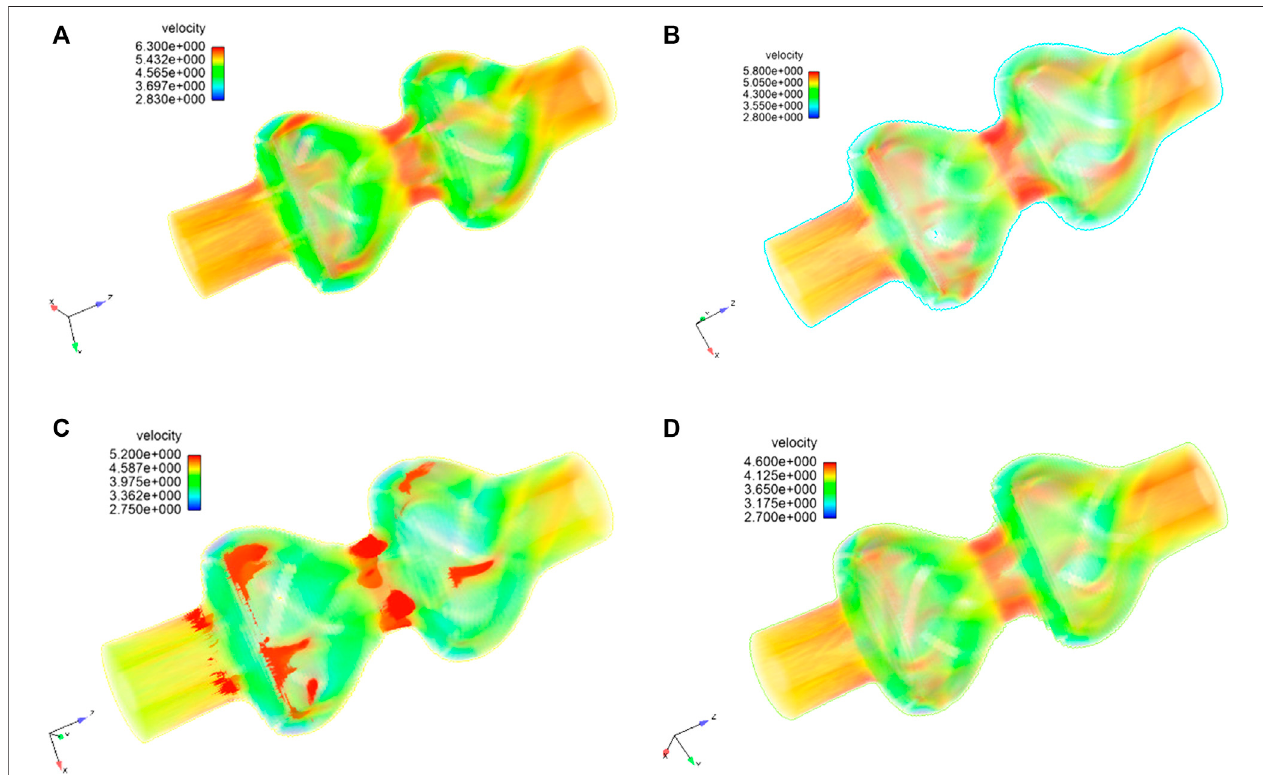
FIGURE3| Axialvelocityclouddiagramsofthe fl ow fi eldofthetwo-stagedeep-sealiftingpump: (A) 1,100 rpm, (B) 1,200 rpm, (C) 1,300 rpm,and (D) 1,450 rpm.